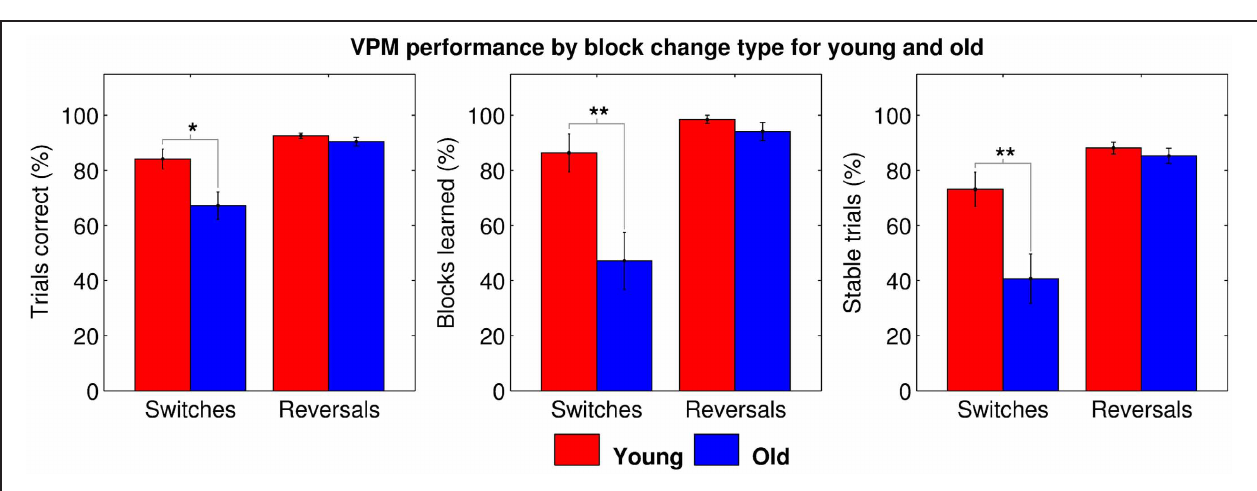
FIGURE 4 | VPM performance in terms of trials correct (left), blocks learned (middle), and stable trials (right) during blocks following switches and reversals for young (red) and old (blue) participants,